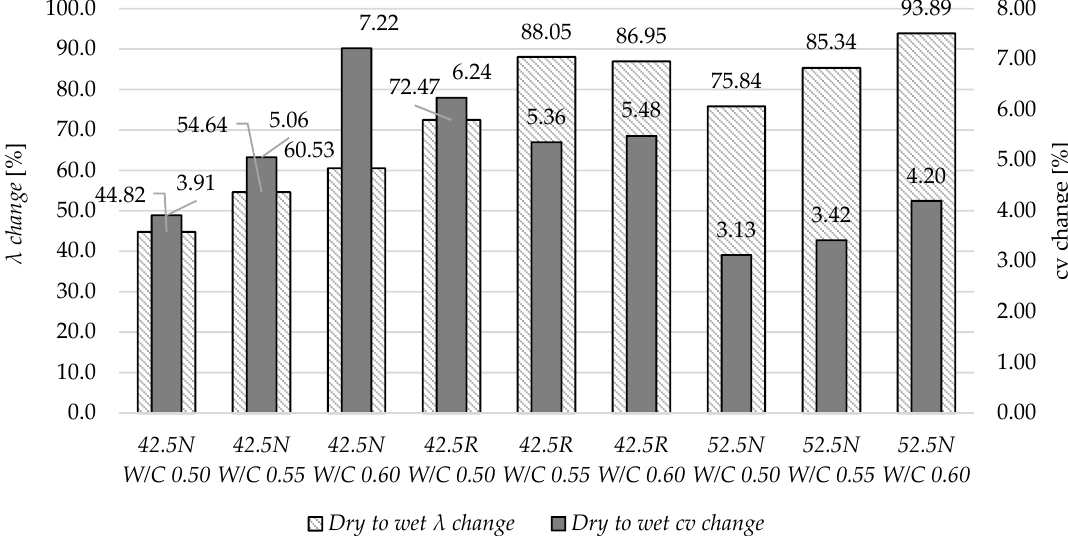
Figure 19. The relative change in the thermal parameter of specimens in dry and saturated state.